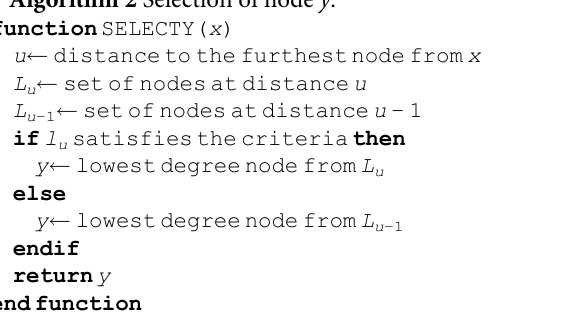
Algorithm 2 Selection of node y .